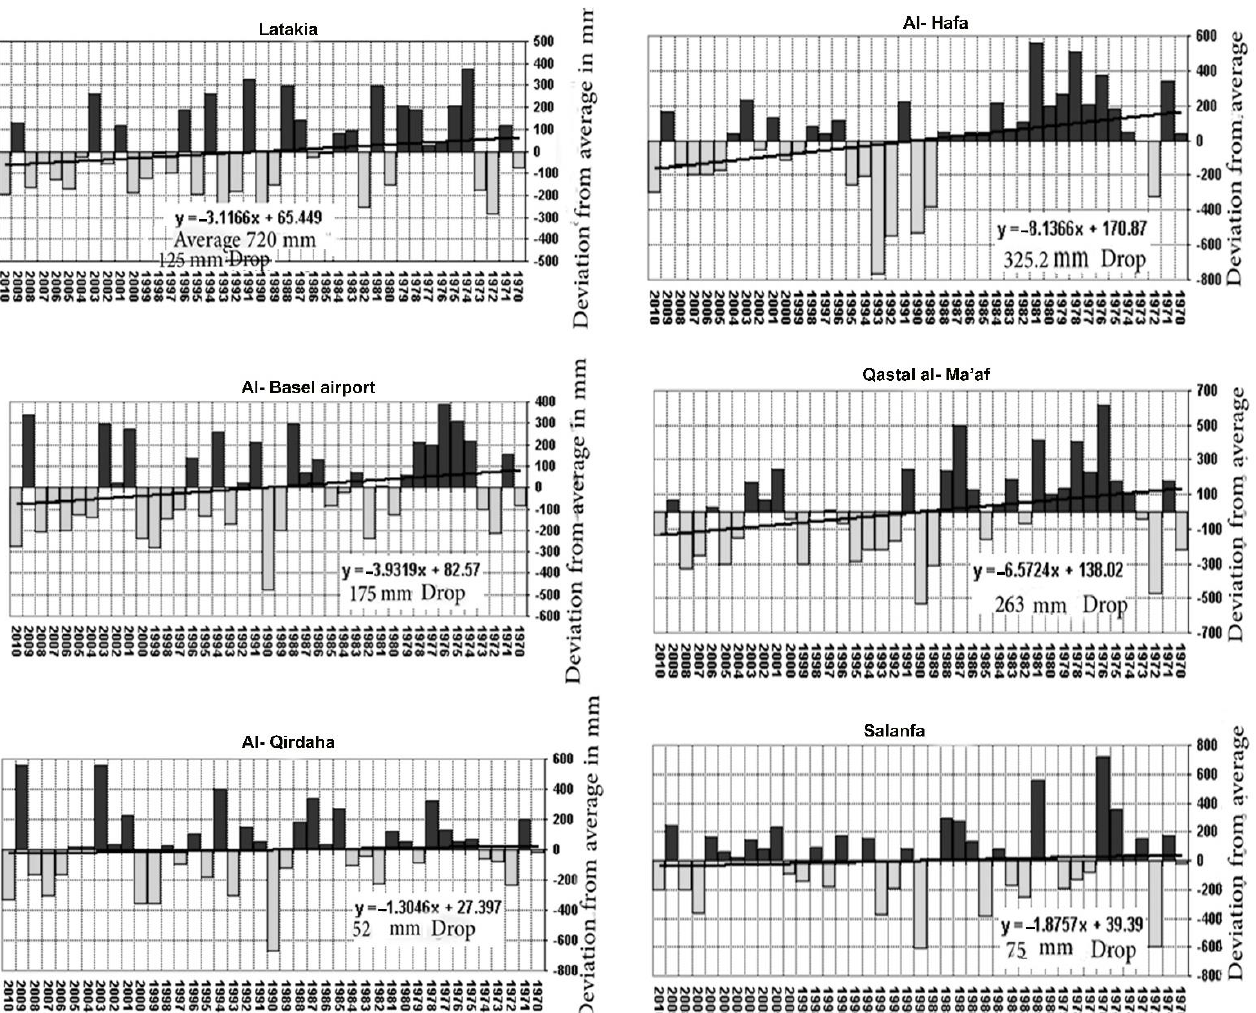
Figure 3. General trend of the mean annual precipitation from 1970–2010.